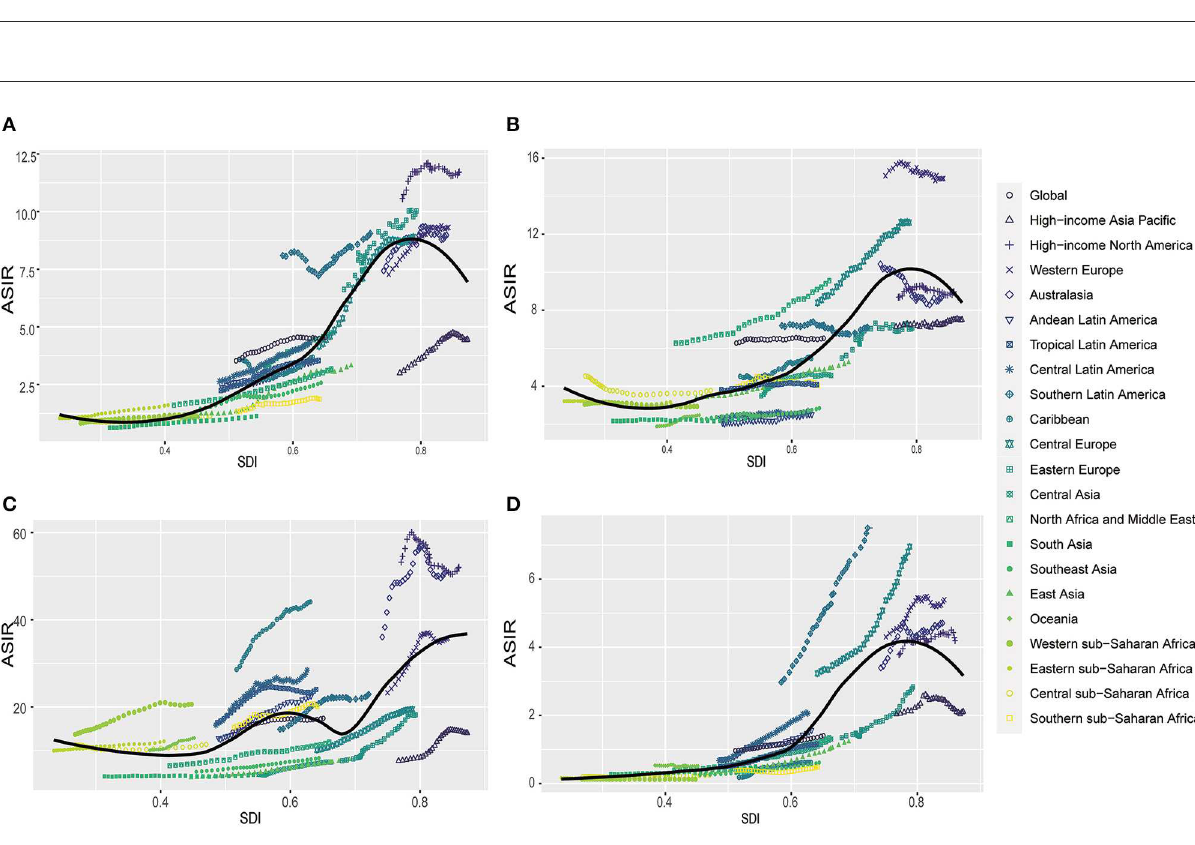
FIGURE2 The correlation between global age standardized incidence rate (ASIR) and socio-demographic index (SDI) for kidney cancer (A) bladder cancer (B) prostate cancer (C) and testicular cancer (D) for both sexes in different regions.